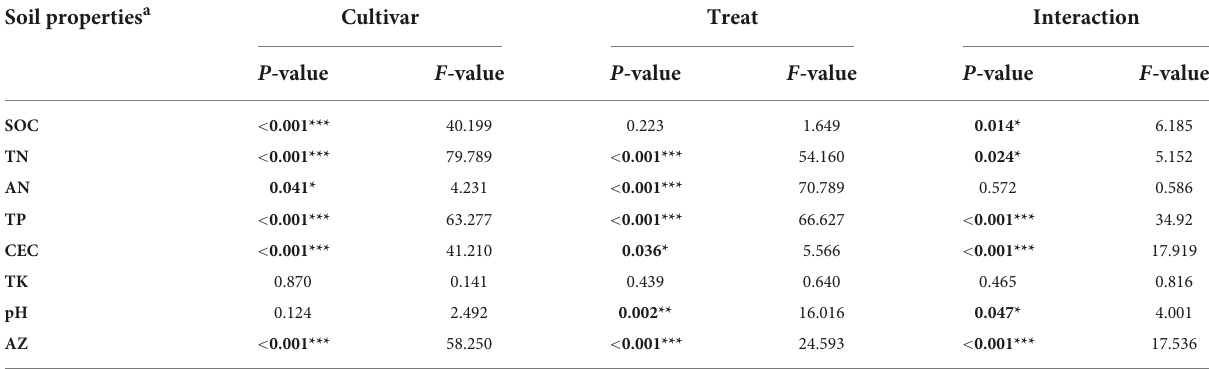
TABLE 4 Two-way ANOVA for soil properties as affected by basal Zn application (treat), rice cultivar (cultivar), and the interaction (treat × cultivar). Soil properties